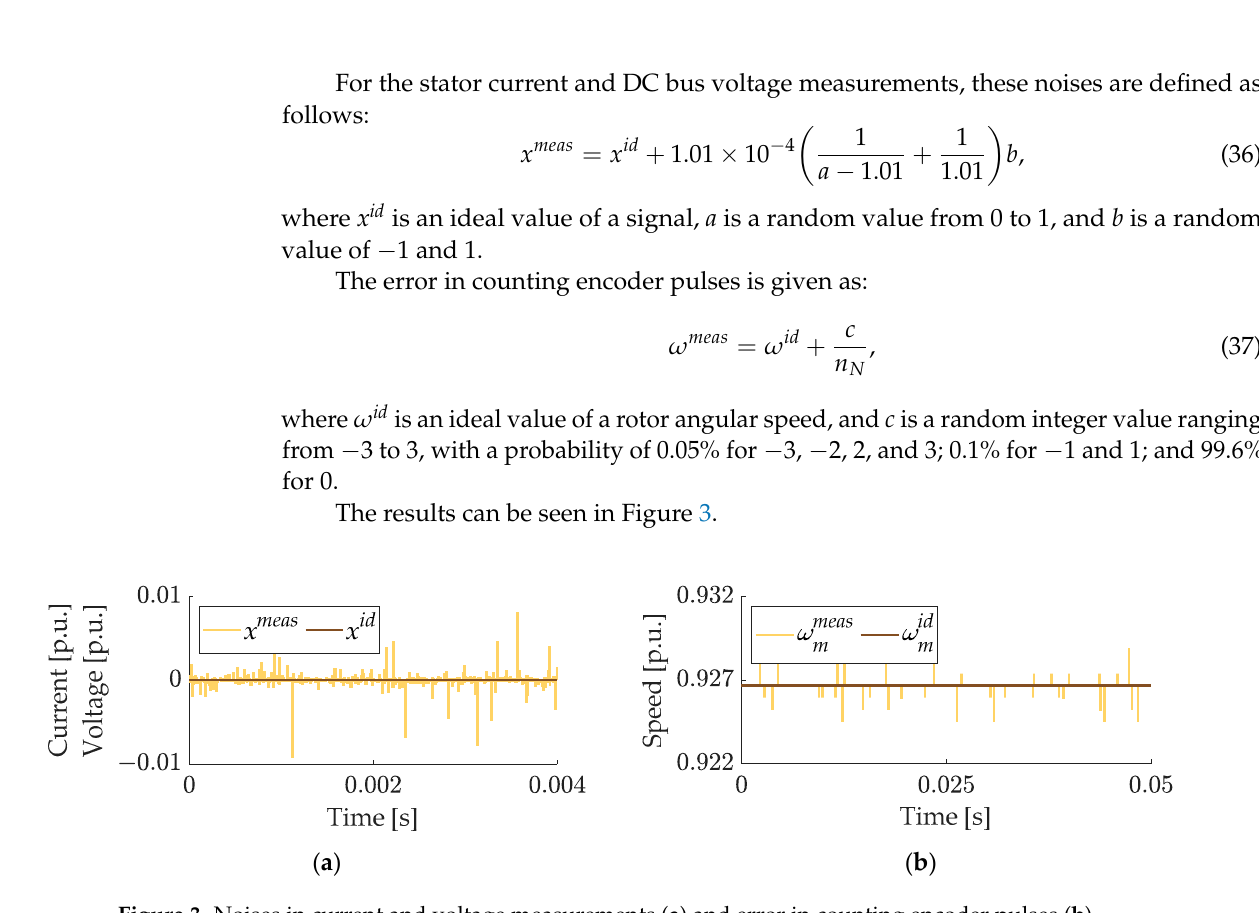
Figure 3. Noises in current and voltage measurements ( a ) and error in counting encoder pulses ( b ).